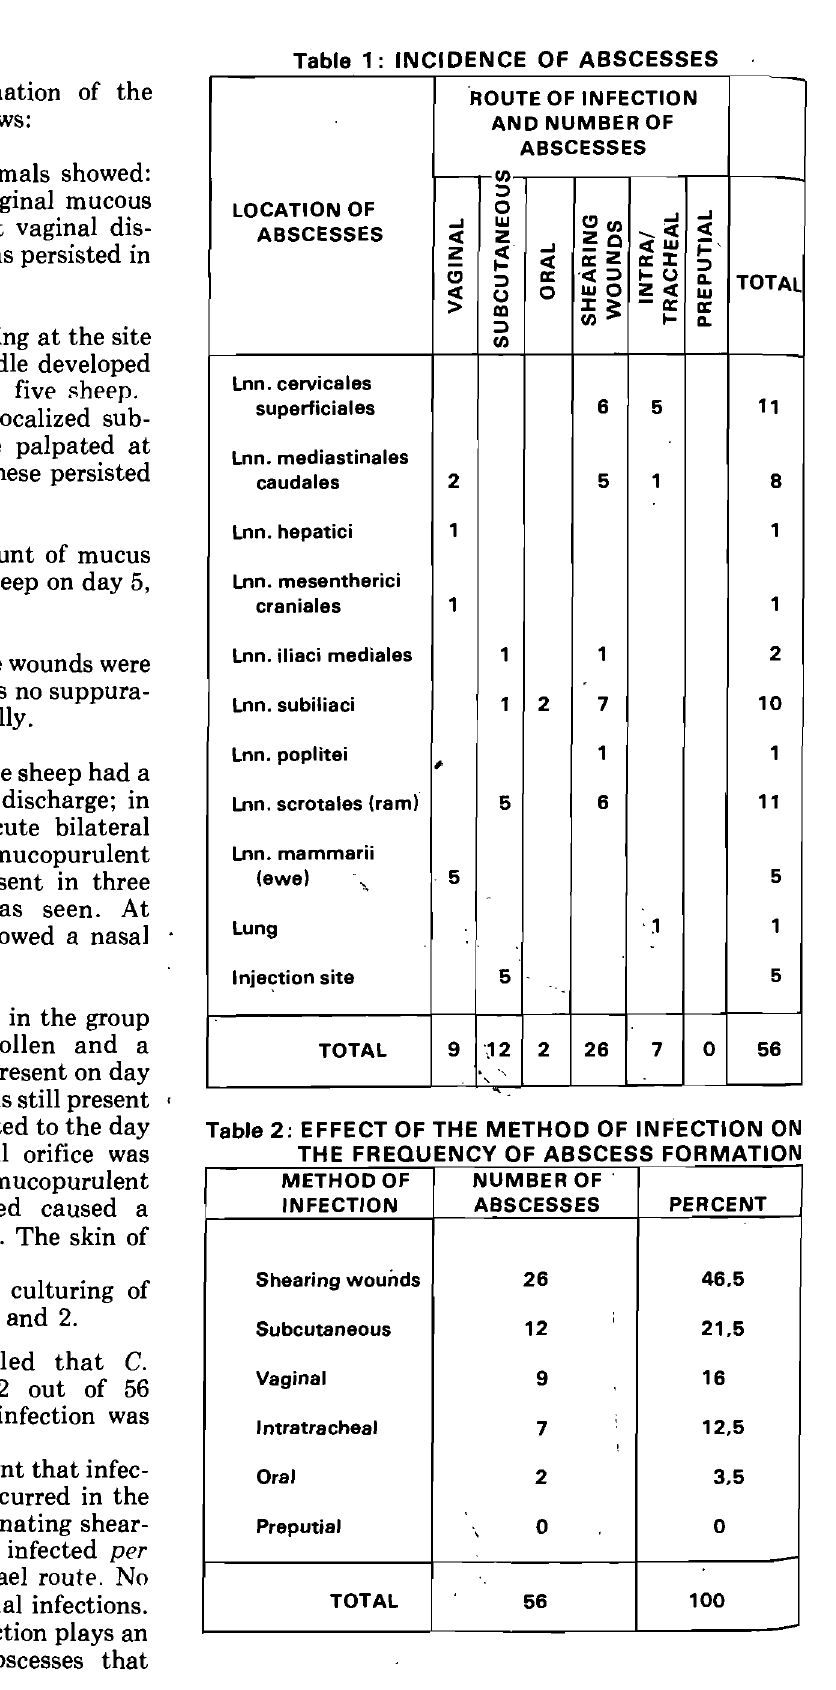
Table 2: EFFECT OF THE METHOD OF INFECTION ON THE FREQUENCY OF ABSCESS